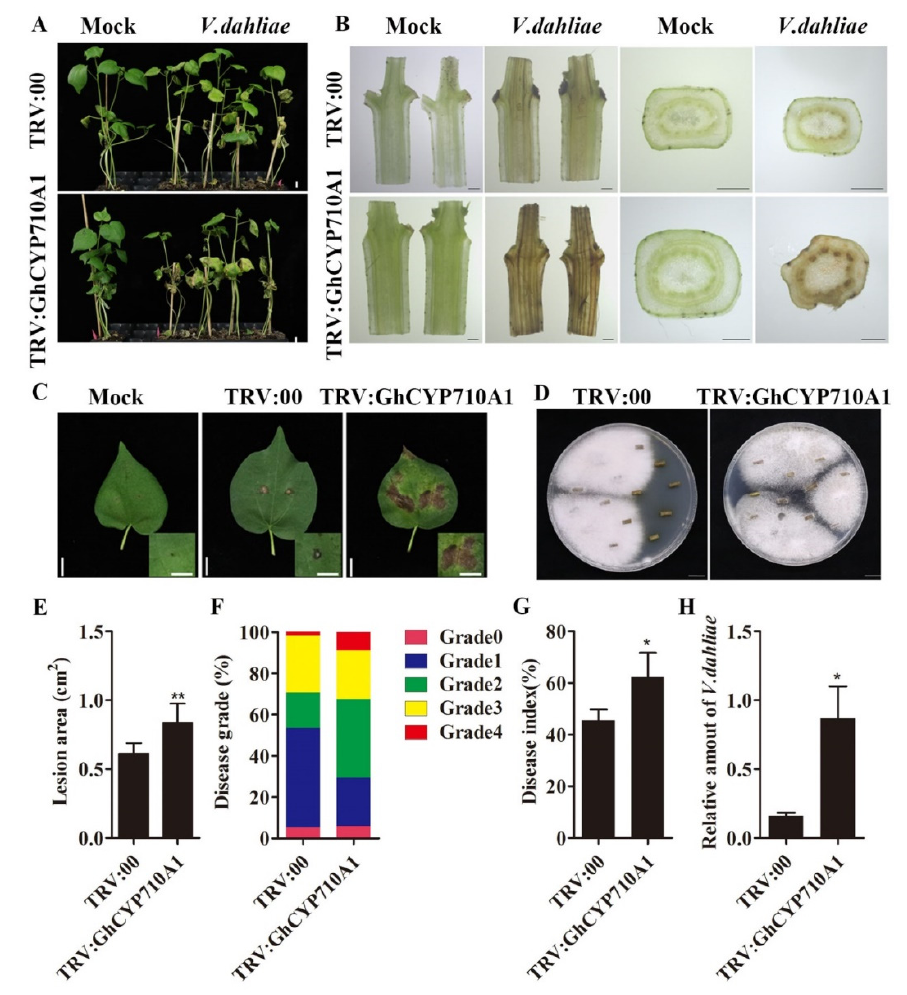
Figure 7. Silencing GhCYP710A1 enhances the sensitivity of plants to Verticillium dahliae . ( A ) Disease symptoms of TRV:00 and TRV:GhCYP710A plants after Verticillium dahliae infection for 15 days. Scale bar = 1 cm. ( B ) The cross- and longitudinal sections of cotton plant stems after Verticillium dahliae infection for 20 days. The brown area represents the diseased vascular tissue. Scale bar = 1 mm. ( C ) Symptoms of cotton leaves after Verticillium dahliae infection for 10 days. Scale bar = 1 cm. ( D ) Stem sections at 20 dpi were plated on potato dextrose agar medium and incubated at 25 °C. Photographs were taken 10 days after culture. Each independent experiment contains 10 plants per treatment. Scale bar = 1 cm. ( E ) The lesions area statistics of cotton after Verticillium dahliae infection. ( F ) Disease grade of cotton plants after Verticillium dahliae infection for 15 days. ( G ) Disease index of cotton plants after Verticillium dahliae infection for 15 days. ( H ) The relative amount of Verticillium dahliae determined by qRT-PCR in TRV:00 and TRV:GhCYP710A1 plants after Verticillium dahliae infection for 15 days. * represents p < 0.05, ** represents p < 0.01.